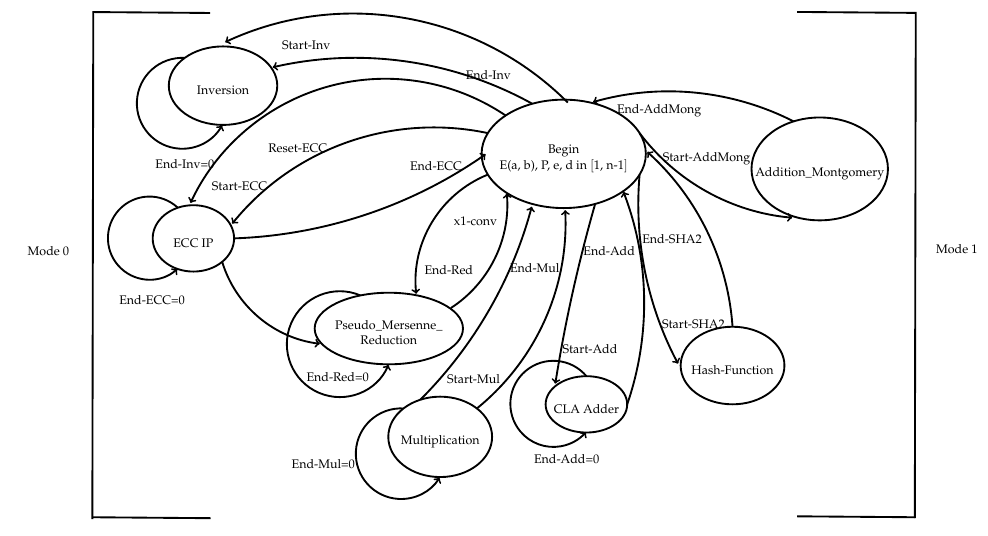
Figure 10. The controller finite state